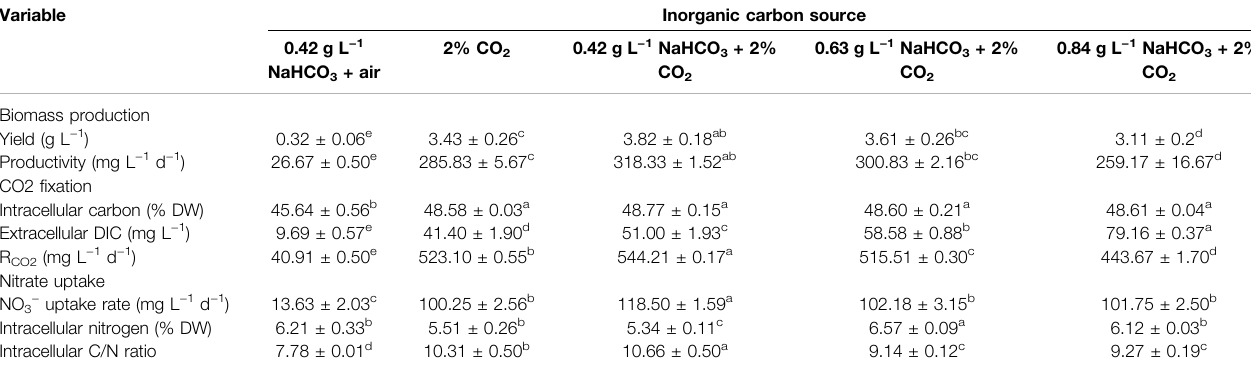
TABLE 1 | Biomass production, CO 2 photosynthetic fi xation, and nitrate uptake by autotrophic C. subellipsoidea under various inorganic carbon sources in shake fl asks.